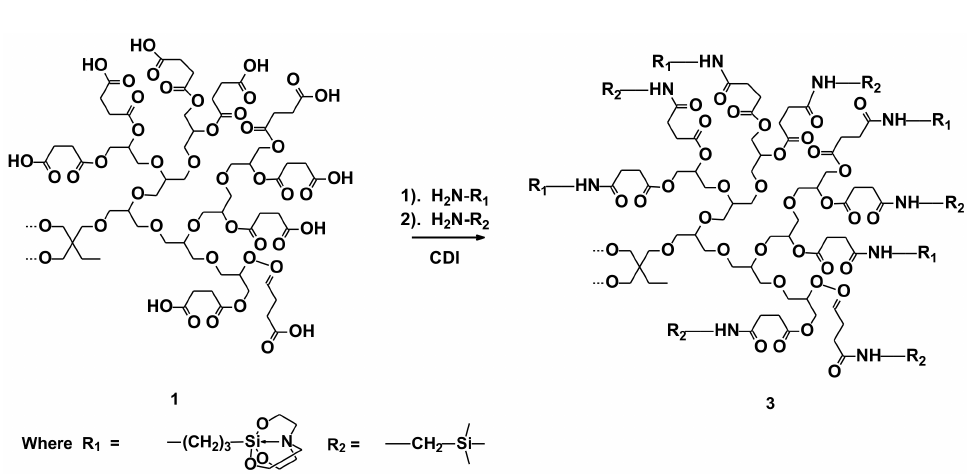
Organosilicon-terminated polymers (3,4) were prepared by sequential reaction of carboxyl-terminated polymers (1,2) with 1-(3-aminopropyl)silatrane and (aminomethyl) trimethylsilane, as shown on Scheme 3; Scheme 4.